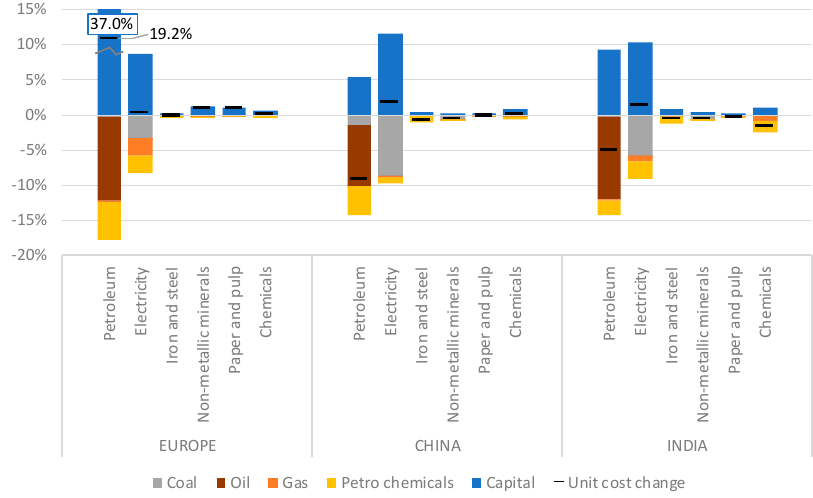
Figure 5. Implemented relative input changes for fossil fuels (Coal, Oil, and Gas), Petroleum, and Capital use, as well as unit cost changes in energy intensive sectors in CGE model for 450 ppm low carbon technologies scenario in Europe, China and India. Percentage deviation relative to economic baseline technology in 2030 (based on [53]).